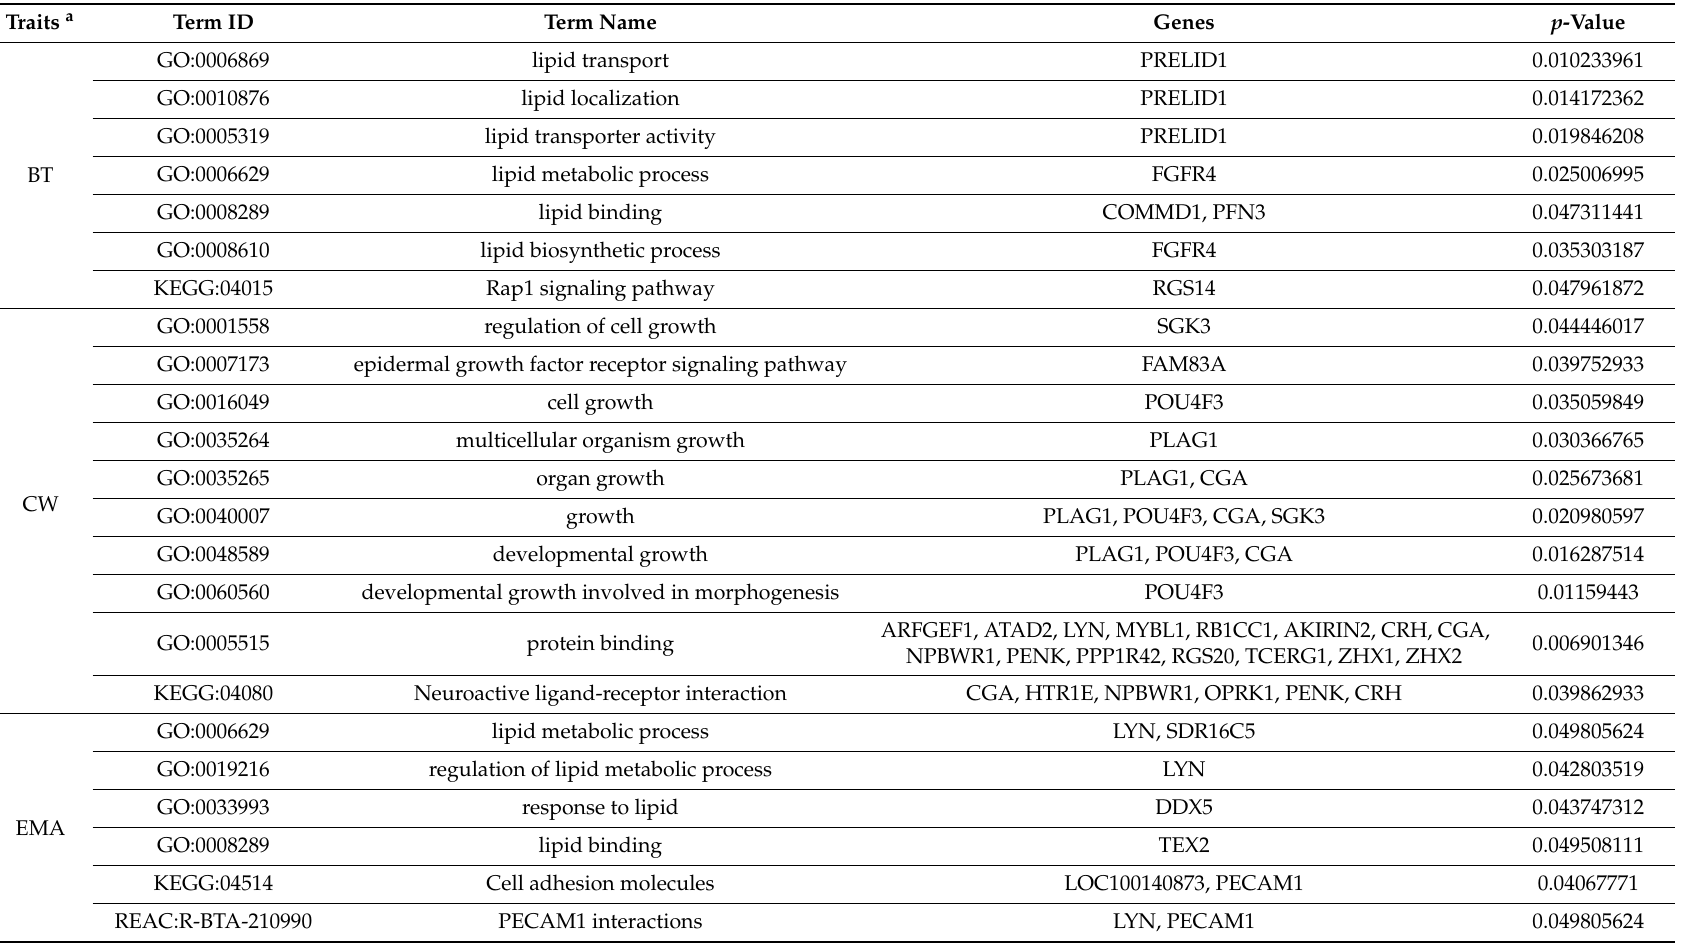
Table 3. Gene Ontology, KEGG and Reactome pathways where the candidate genes are significantly enriched ( p <